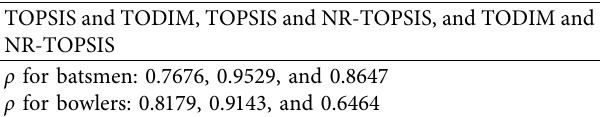
Table 14: Spearman Rank Correlation Coefficient results of TOPSIS, TODIM, and NR-TOPSIS. TOPSIS and TODIM, TOPSIS and NR-TOPSIS, and TODIM and